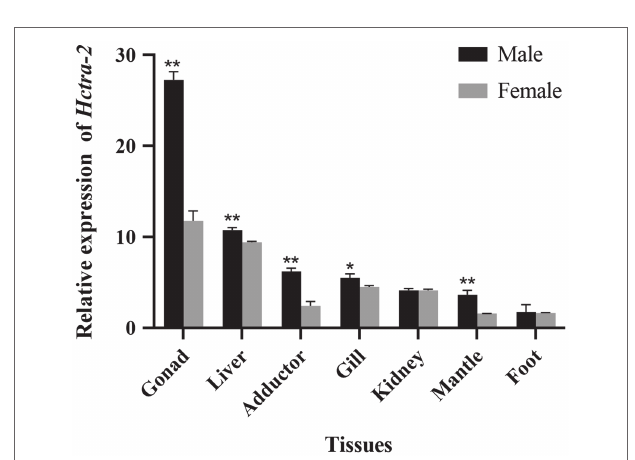
FIGURE 4 | Tissues expression of Hctra-2 gene in adult male and female H. cumingii . Results are expressed as mean ± SD, and significance of comparison is defined as p < 0.05 (*) or p < 0.01 (**) by Student’s t -tests.